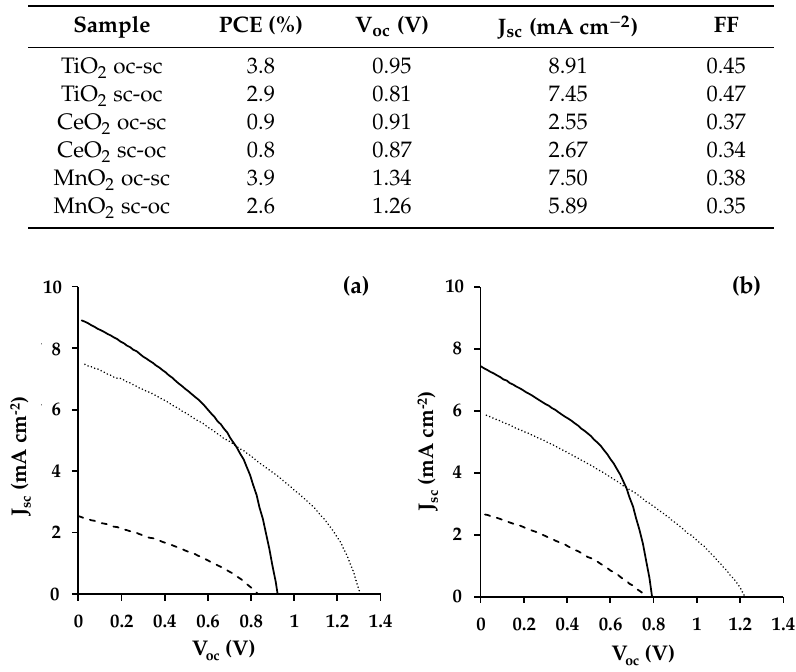
Figure 4. PSC I-V data scanned from ( a ) open circuit to short circuit and ( b ) short circuit to open circuit fabricated using metal oxide scaffolds consisting of TiO 2 (solid line), CeO 2 (dashed line), or MnO 2 (dotted line).